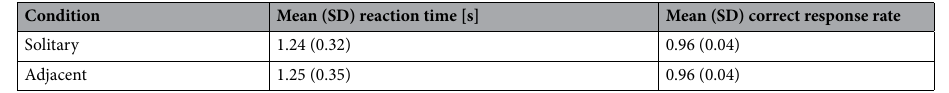
Table 1. Mean (standard deviation [SD]) reaction time and correct response rate for the adjacent and solitary